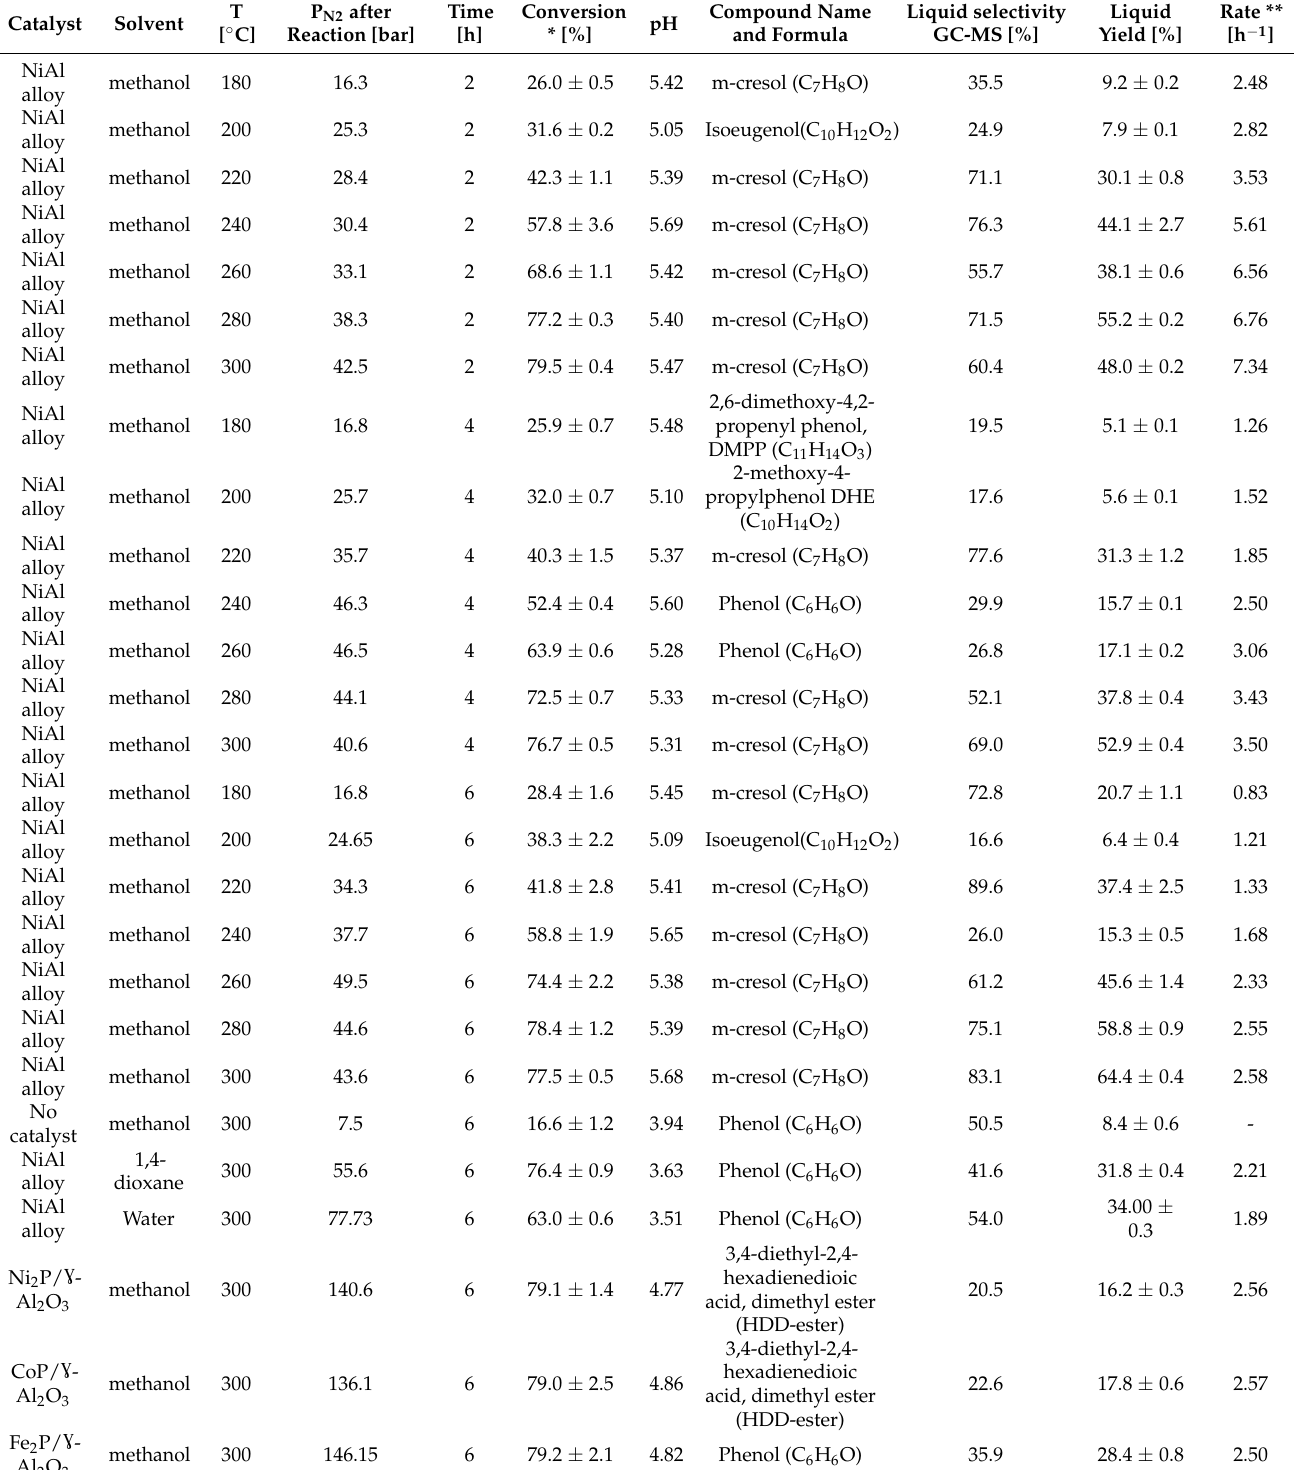
Table 4. Summary of date palm fractionation analysis results from a reactor charged with 2 bars initial N 2 pressure, 5 wt.% catalyst loading with respect to biomass amount, 2 g biomass, and 180 µ m biomass particle size.